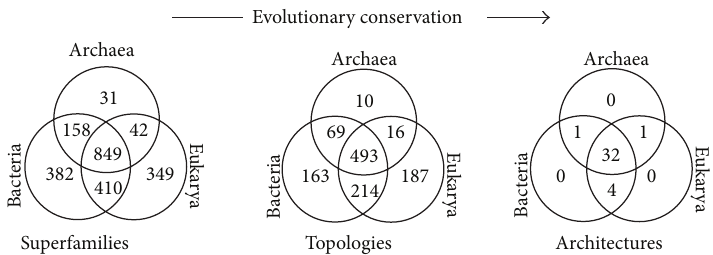
Figure 12: Venn diagrams displaying the distributions of 2,221 homologous superfamilies, 1,152 topologies, and 38 architectures of CATH domains in the proteomes of 492 fully sequenced genomes (from [145]). All distributions highlight maximum sharing in the ancient ABE and BE taxonomic groups and minimal sharing in archaeal taxonomic groups.